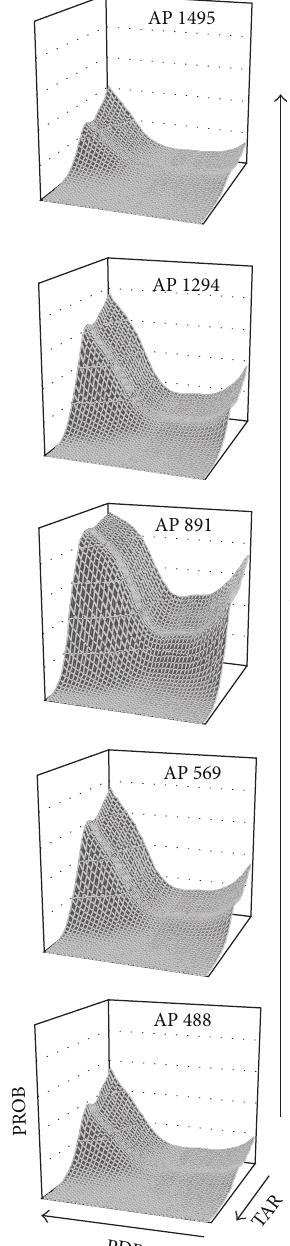
Figure 5: Three-dimensional representation of the three-term model at five values of annual precipitation (AP) in mm. Values on the x , y and z -axes of each graph range between 0 and 21.6 mm for precipitationofthedriestperiod(PDP),13.6–29.4 ∘ Cfortemperature annual range (TAR), and 0-1 for probability